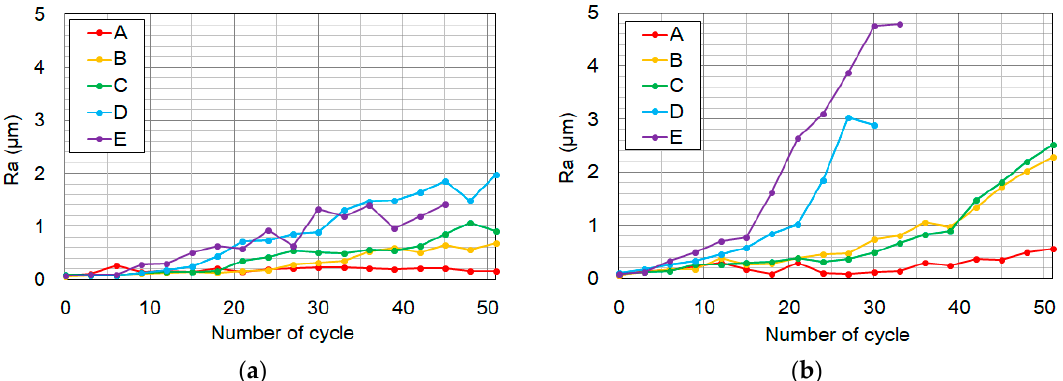
Figure 8. Change in Ra with number of cycle in the 50-cycle tests. ( a ) 1 mm air ga; ( b ) 2 mm air gap.